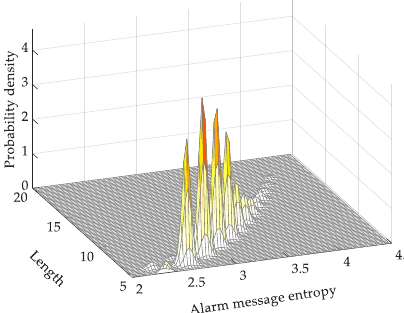
Figure 4. Probability density map of absolute alarm-message entropy.